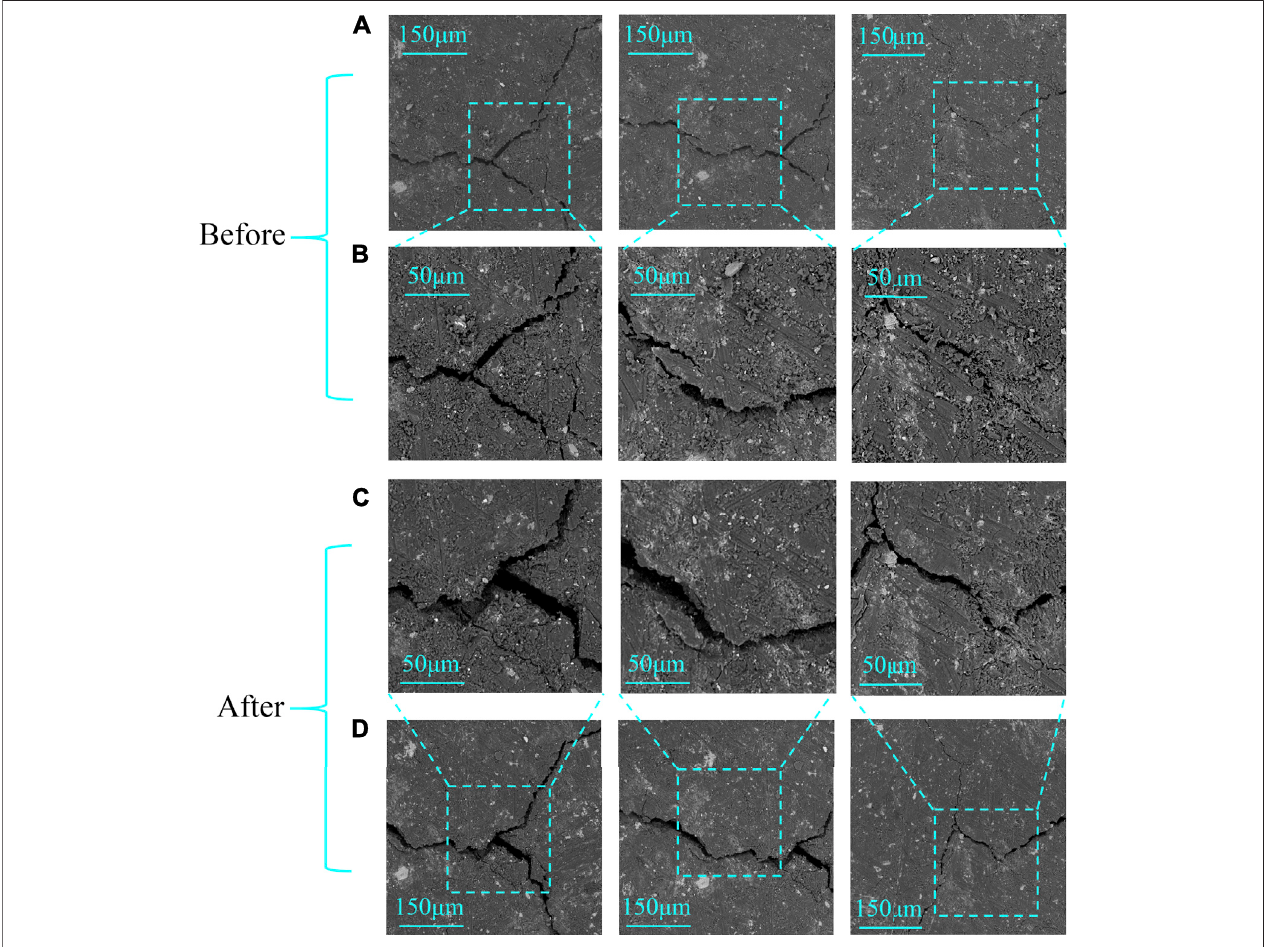
FIGURE 2 | SEM images before (A,B) and after (C,D) the reaction; rows (B,C) are in high resolution, while rows (A,D) are in low resolution.